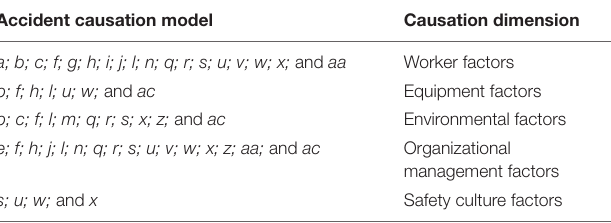
TABLE 2 | The first-level intermediate events of fault tree analysis